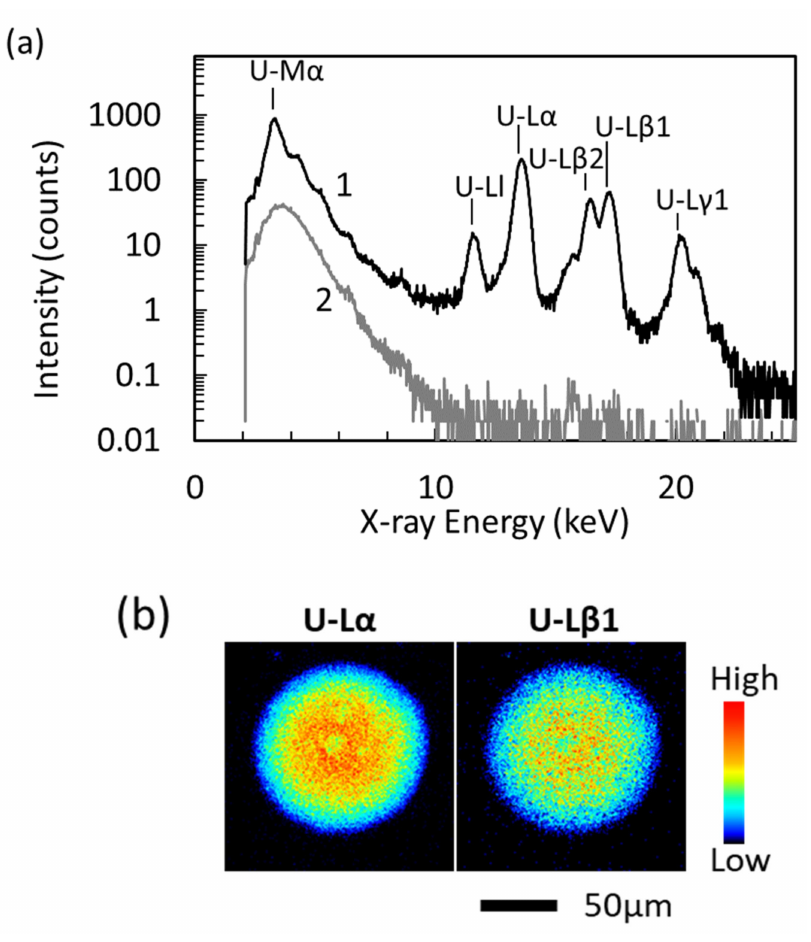
Figure 1. ( a ) µ -PIXE spectra of 1 µ L of 50 µ g/g U in 0.1M HNO 3 for curve 1 and that of blank for curve 2. ( b ) U images at U-L α and U-L β 1 lines.